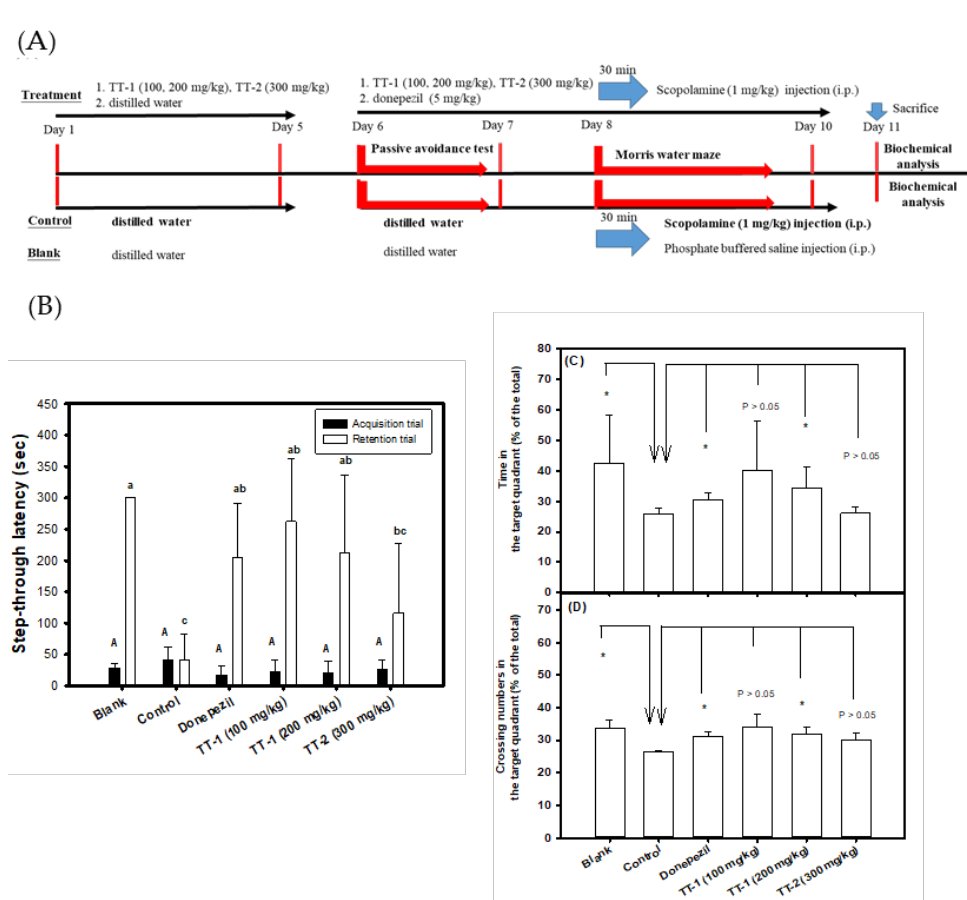
Figure 5. Effects of TT-1 (100 and 200 mg/kg) or TT-2 (300 mg/kg) treatments on improvements in learning and memory functions in scopolamine-induced amnesiac mice (six heads/group). ( A ) The experimental protocol, which included three treatment groups, one donepezil-positive control group, one control group, and one blank group; ( B ) the step-through latency (sec) in the passive avoidance test; ( C ) the swimming time in the target quadrant (% of total) in the probe test of the Morris water maze; ( D ) the crossing numbers in the target quadrant (% of total) in the probe test of the Morris water maze. The mice in the control group were injected with scopolamine only in the parallel experiment. Comparisons among multiple groups in the step-through latency ( B ) were performed using one-way analysis of variance (ANOVA) and the post hoc Tukey’s test, and the different uppercase letters in the step-through latency in the acquisition trial or the different lowercase letters in the retention trial were considered significantly different ( p < 0.05) among groups. Student’s t-test was used to compare treated groups with the control group in the probe test of the Morris water maze ( C , D ), and any difference was considered statistically significant when p < 0.05 (*).